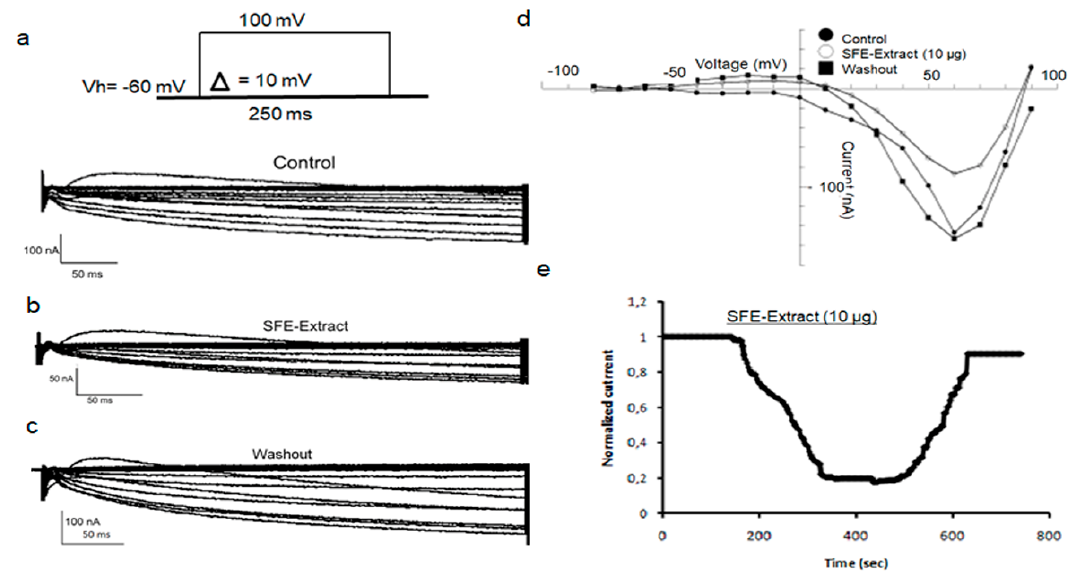
Figure 4. Reversible inhibitory effect of SFE-Extract on endogenous currents in Xenopus oocytes in